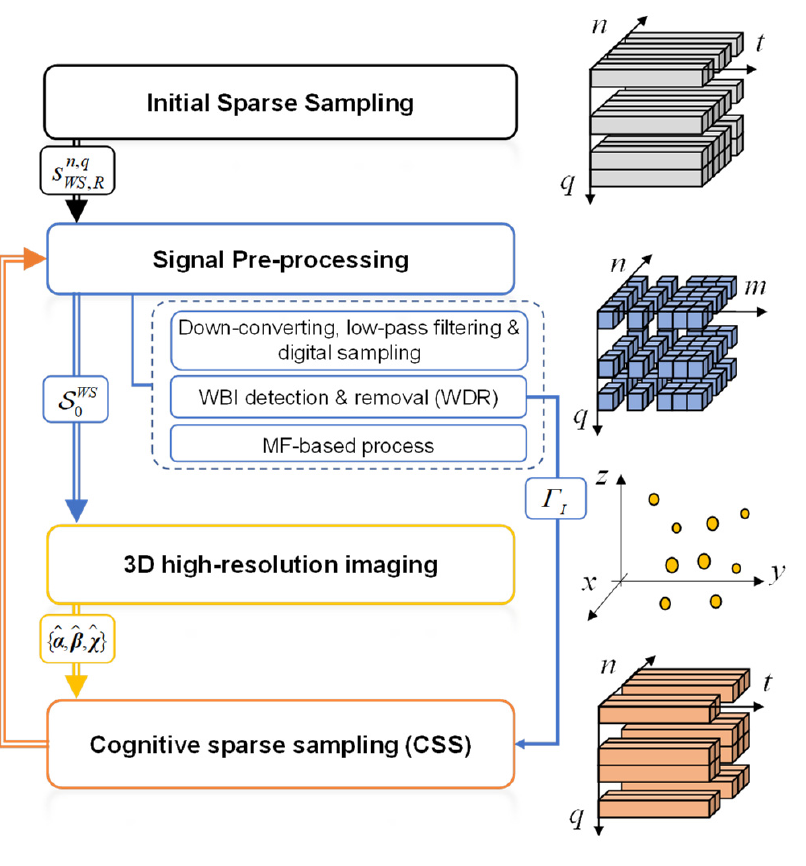
Figure 6. Flowchart of the proposed cognitive sparse imaging method.